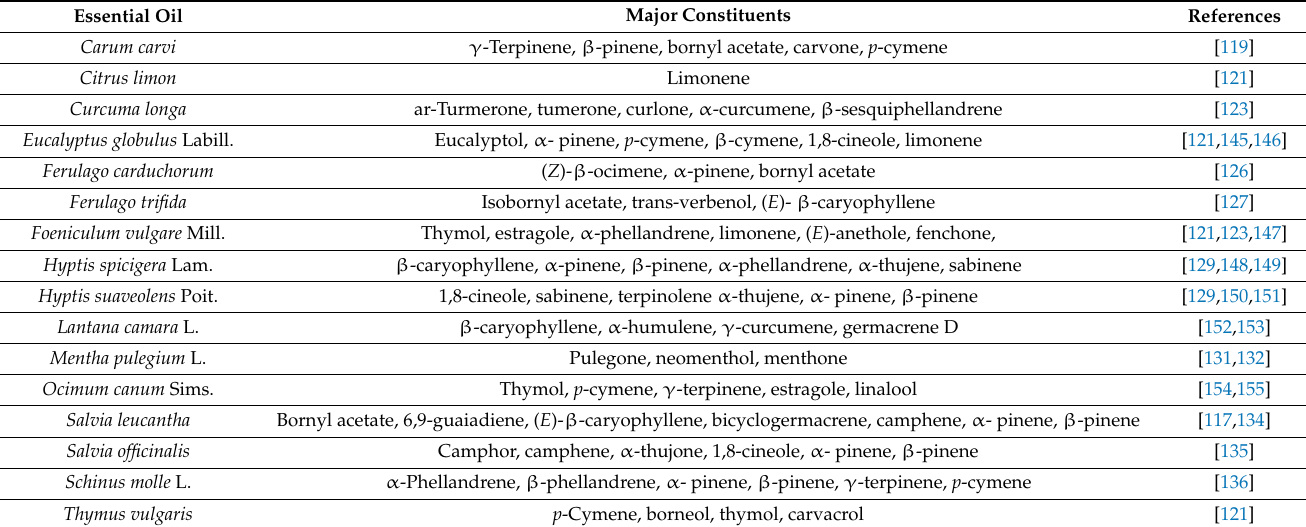
Table 2. Major constituents of EOs with anticholinesterase insecticidal